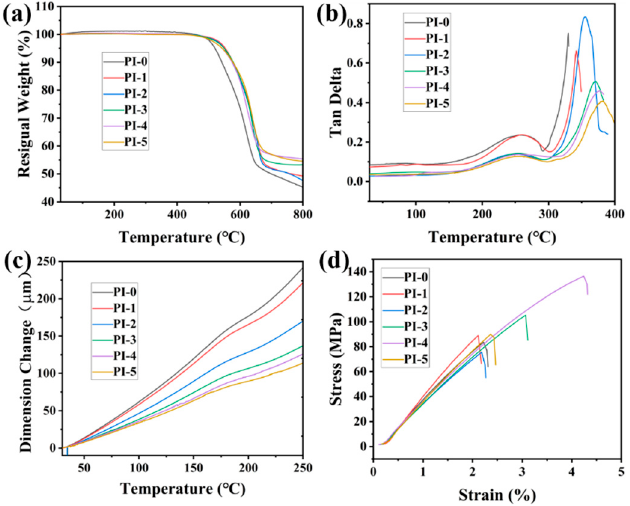
Figure 4. ( a ) The TGA curves of CPIs; ( b ) The DMA curves of CPIs; ( c ) The TMA curves of CPIs; ( d ) The stress–strain curves of CPIs. Table 2. The thermal properties, mechanical properties, and surface properties of the CPIs.